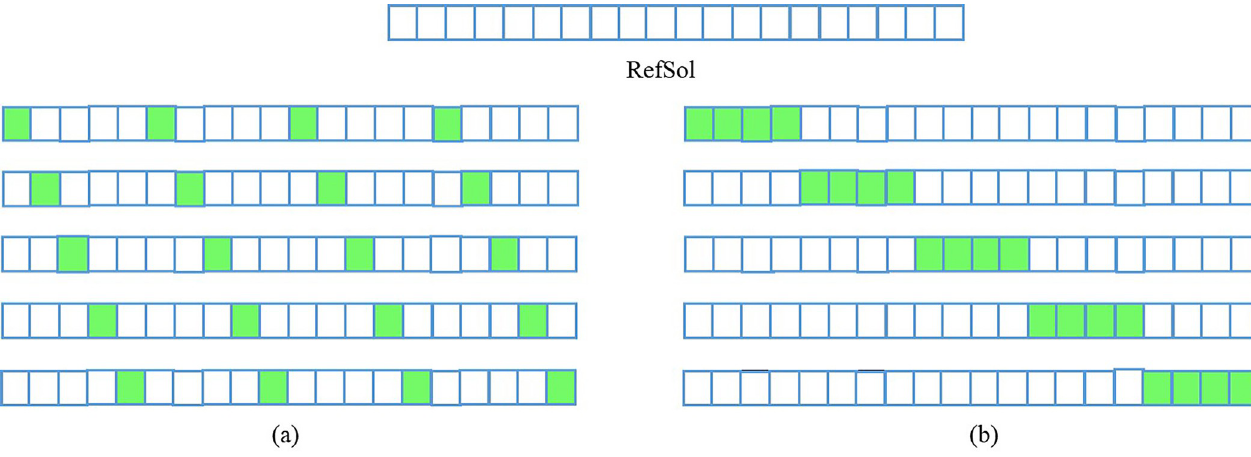
Fig 4. (a) solutions generated by the first strategy, (b) solutions generated by the second strategy.